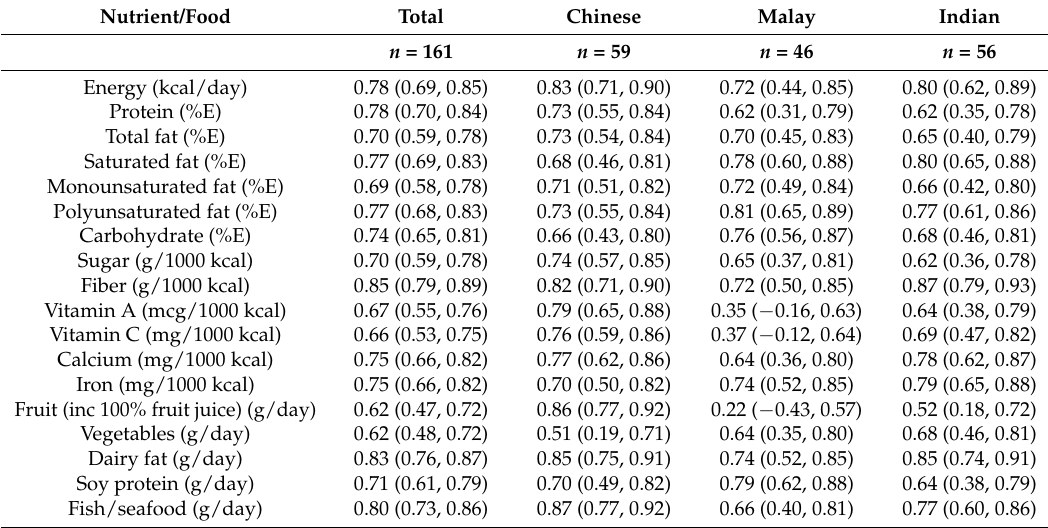
Table 2. Reproducibility (intra-class correlation coefficients) for repeat FFQ administrations with a six-month interval, in the total group and according to ethnicity.